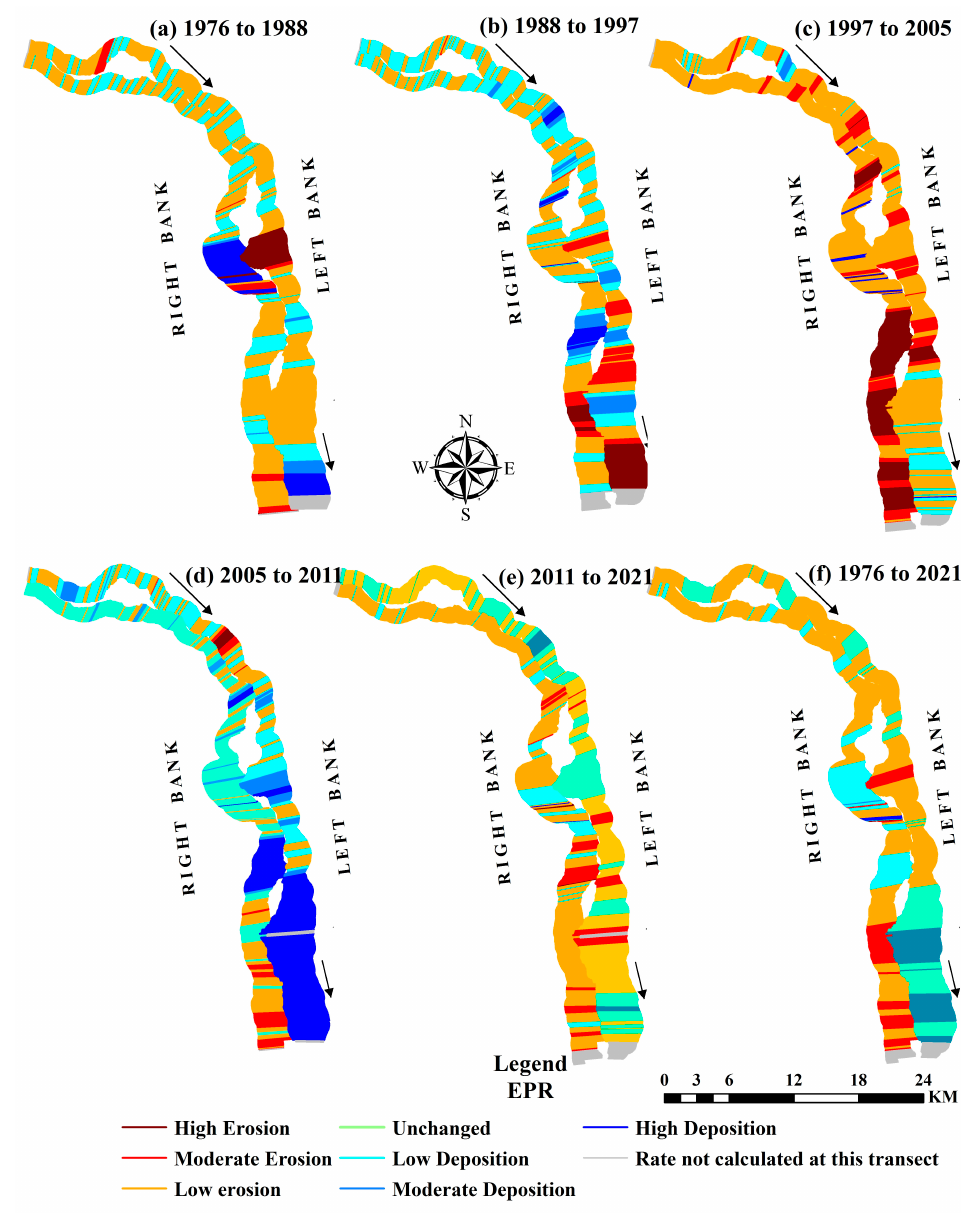
Figure 4. EPR-based channel migration rate (erosion and deposition) during the periods of ( a ) 1976 to 1988, ( b ) 1988 to 1997, ( c ) 1997 to 2005, ( d ) 2005 to 2011, ( e ) 2011 to 2021, and ( f ) 1976–2021. From 1988 to 1997, the average erosion and deposition rates were − 25.27 and − 35.99 m/y and 35.99 and 26.53 m/y in the right and left banks, respectively. During this time, the right and left banks registered average shifts of 0.52 m/y and − 9.04 m/y, respectively (Tables 3 and 4), which were less than that during the previous period. Deposition was more active in the right bank, whereas erosion predominated in the left bank (Figures 4 and 5). The average rate of shifting was negative in the left bank and positive in the right bank. Zone C had the highest level of dynamic activity, followed by zone B (Figure 6). Overall, in this period, both erosion and deposition rates were lower than that accruing during